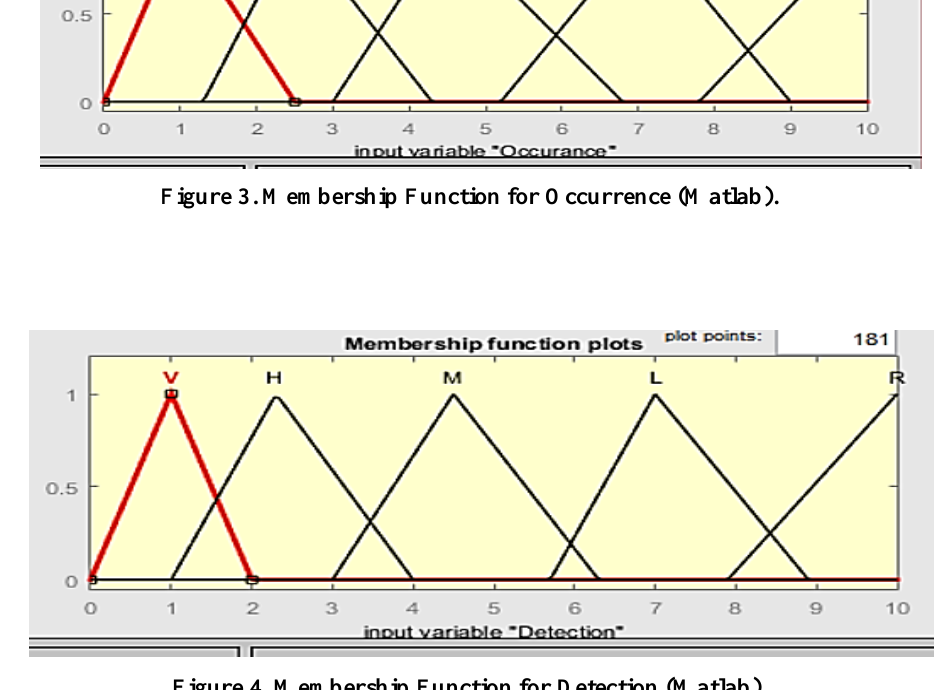
Figure 4. Membership Function for Detection